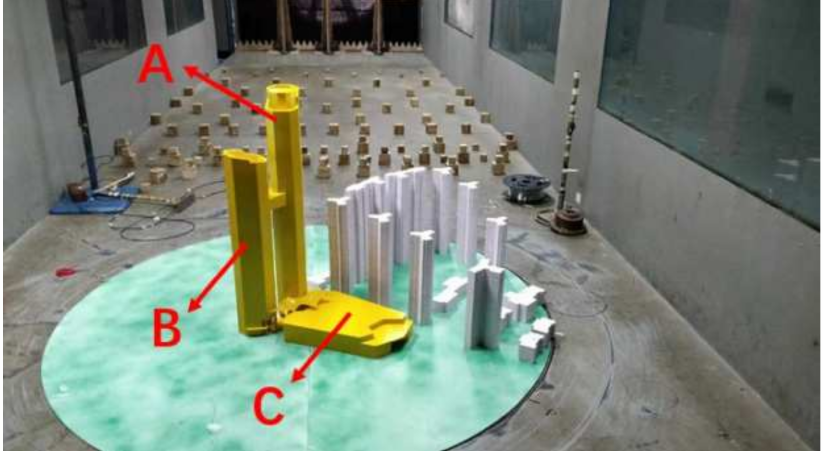
Figure 2. Distribution of wind tunnel experimental models. ( A ) tower A, 280 m high, the scale ratio is 1:300; ( B ) tower B, 200 m high, the scale ratio is 1:300; ( C ) commercial